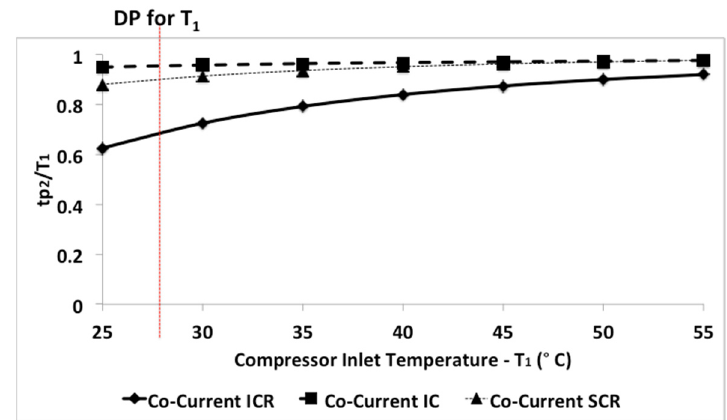
Figure 11. Comparison of Heat Sink Outlet Temperature for the Co ‐ Current Precooler. The heat sink outlet temperature is normalised by the respective cycle/compressor inlet temperatures.